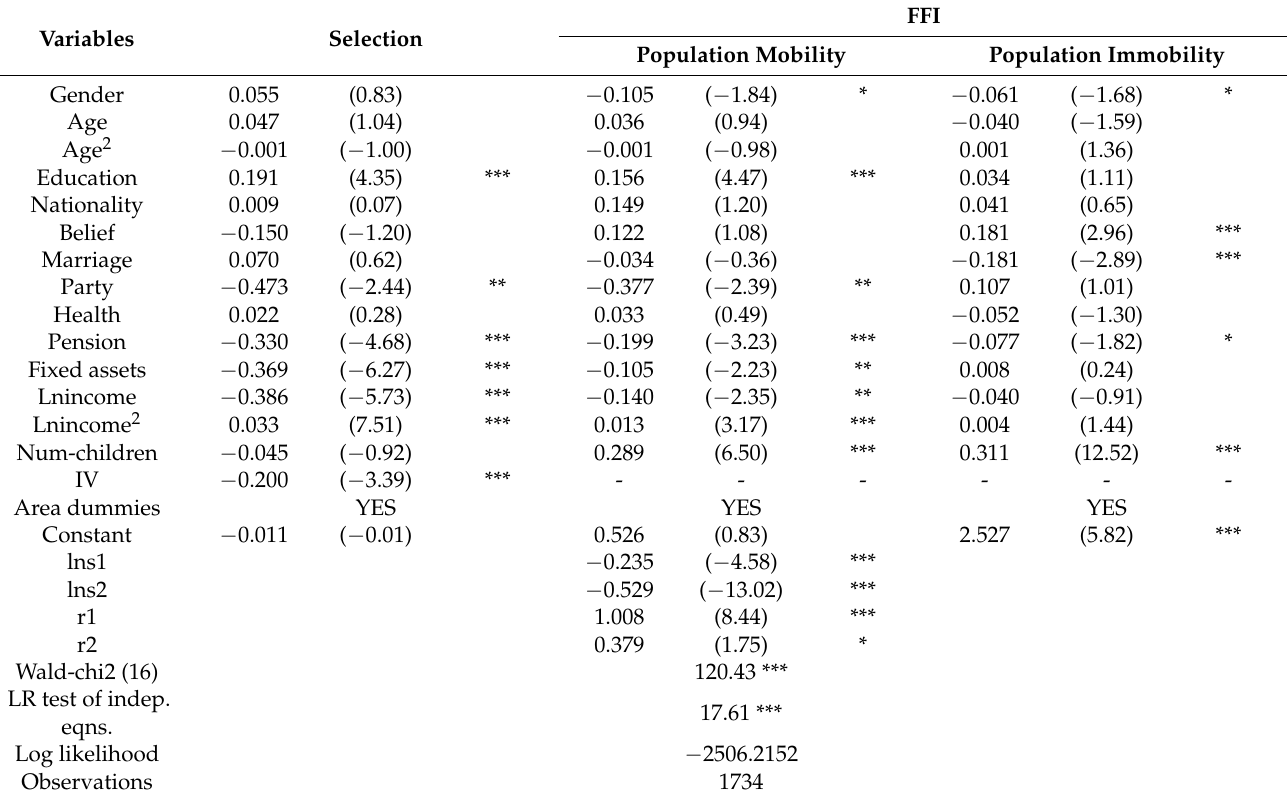
Table 4. The estimates for the determinants of RPM and